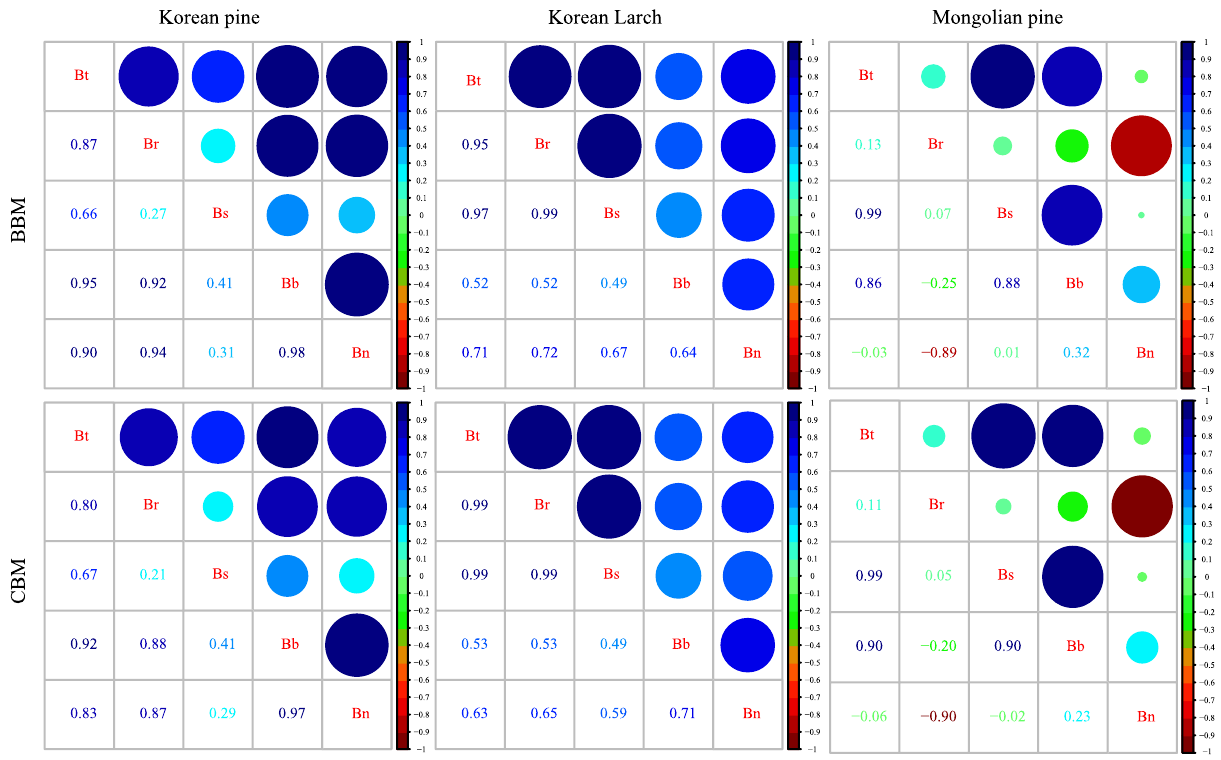
Figure 4. The residual correlation matrices of basic stand biomass models (BBMs) and climate-sensitive stand biomass models (CBMs) for three species. The circle is larger when the correlation coefficient is near 1 and −1 . The circle is smaller when the correlation coefficient is close to 0. The Bt, Ba, Br, Bs, Bb, and Bn represents stand total, belowground, stem, branch, needle biomass, respectively.